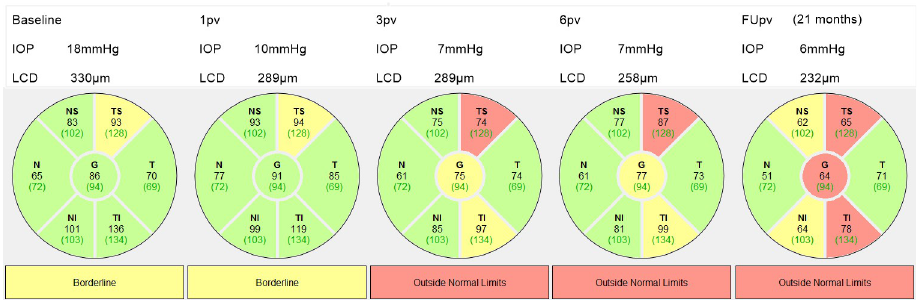
Fig 6. The time course of RNFL thinning with the corresponding IOP and LCD measurements for the left eye of an 81-year-old female patient. FUpv at 21 months. G = global, TS = temporal superior, T = temporal, TI = temporal inferior, NS = nasal superior, N = nasal, NI = nasal inferior.